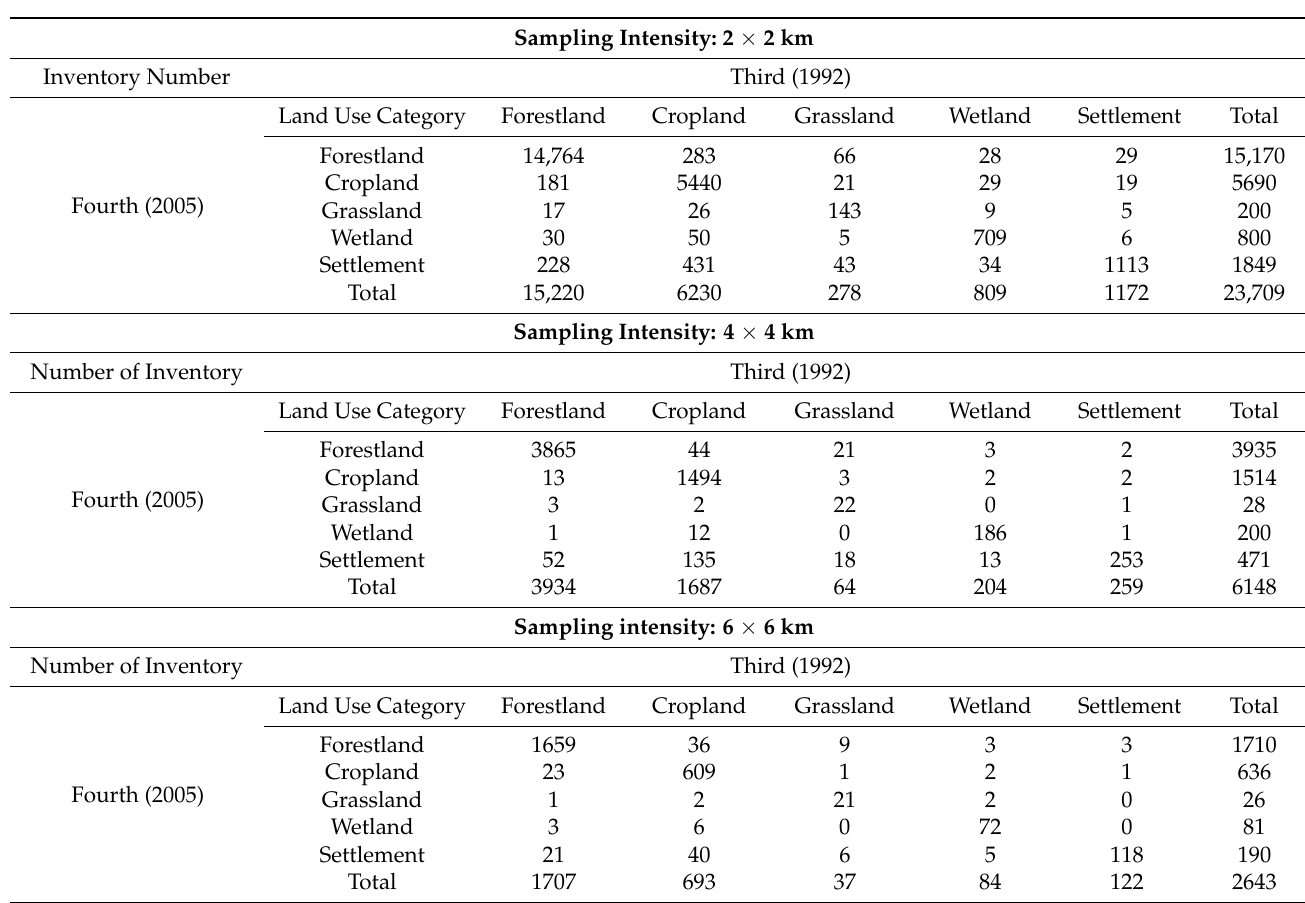
Table 2. Land-use change matrices of optimal sample point units by sampling intensity from analyses of the 3rd (1992) and 4th (2005) aerial